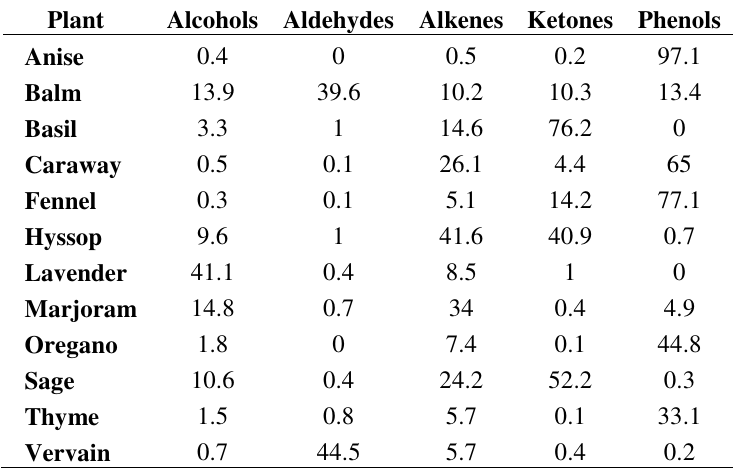
Table 2. Percentage composition of twelve essential oils on the basis of their chemical groups.